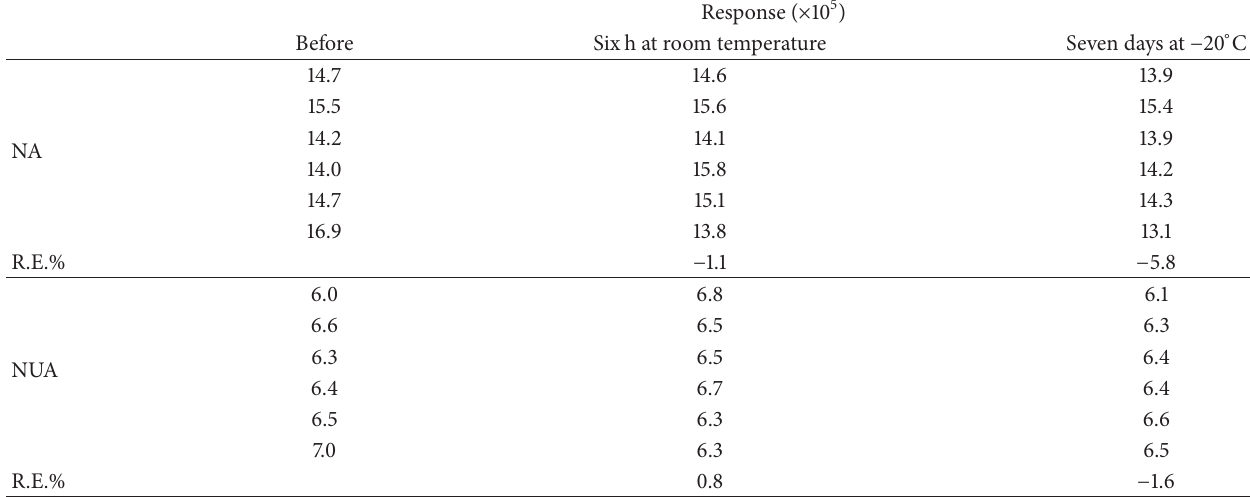
Table 2: Stability data for stock solutions of NA and NUA 6 h in room temperature and 7 days at − 20 ∘ C (before and